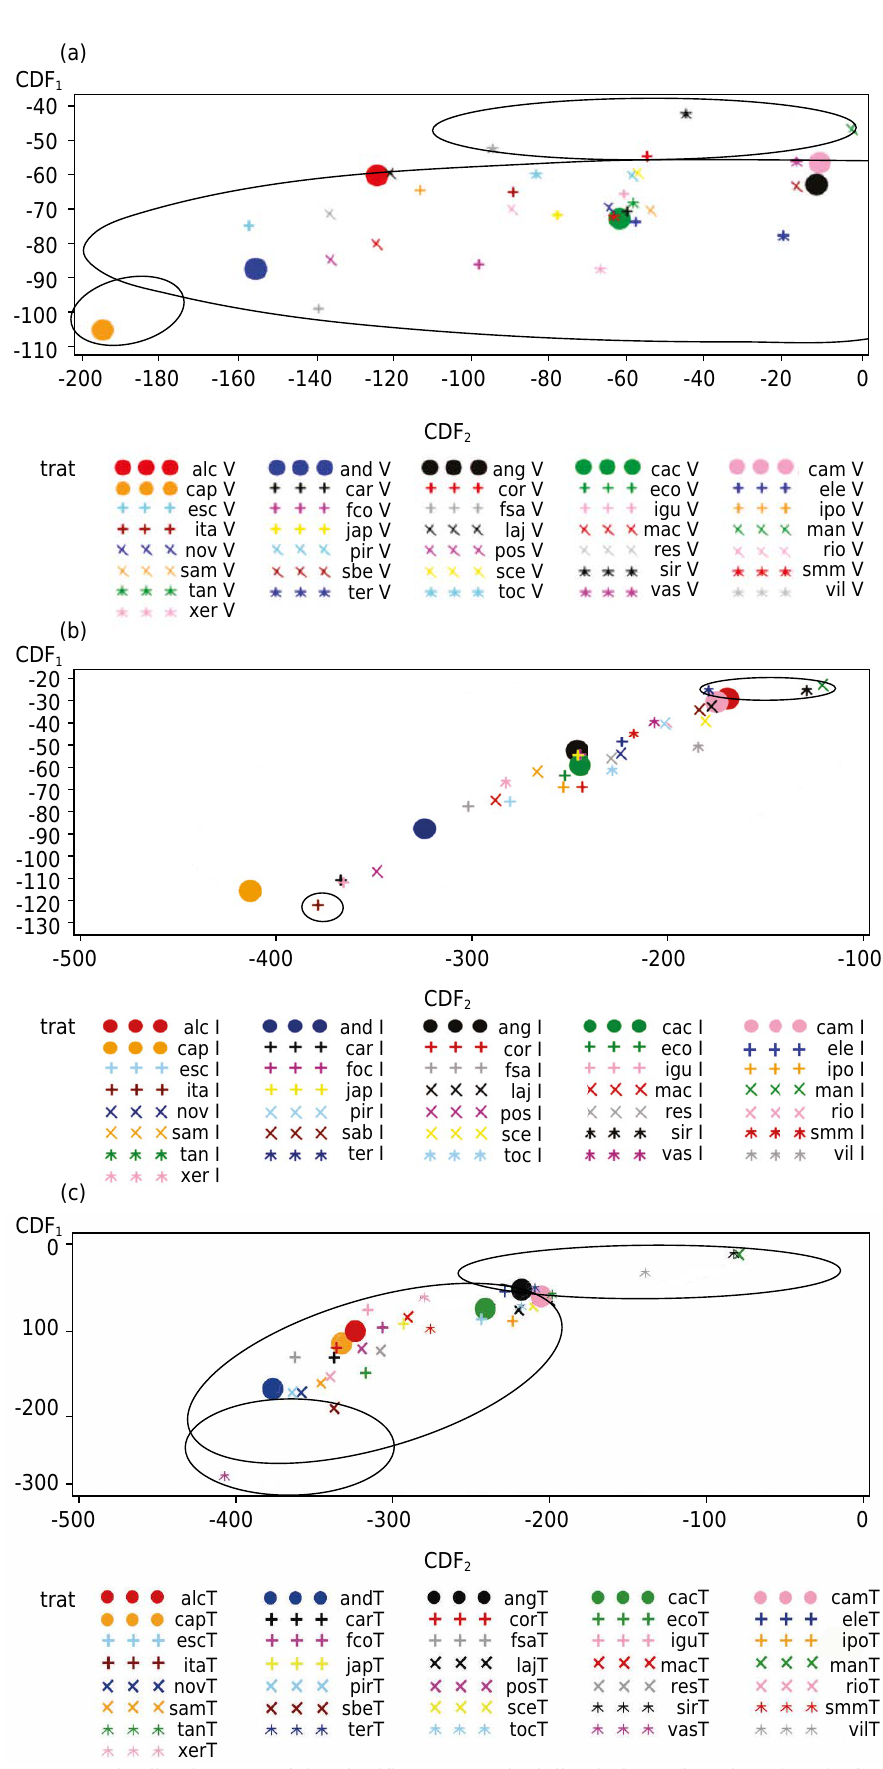
Figure 4. Standardized scores of the significant canonical discriminant functions (CDF) of rainfall and erosivity attributes in the advanced (a), intermediate (b), and delayed (c) patterns for the 36 localities of the state of Rio de Janeiro,